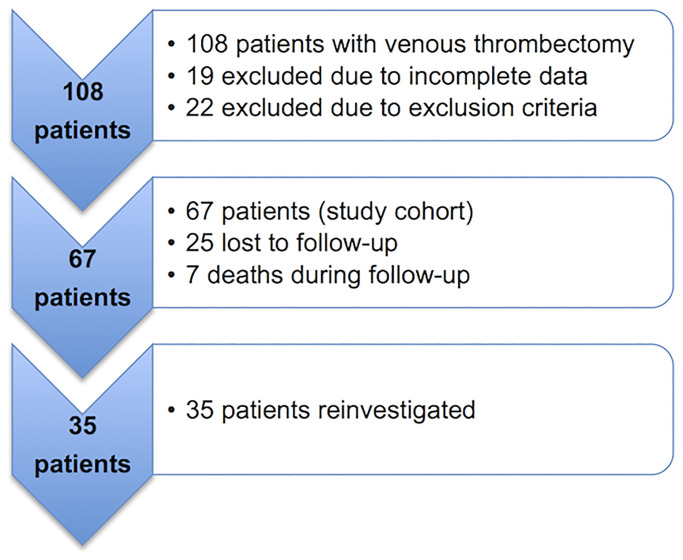
Patient recruitment.A total of 67 patients were included. 35 patients could be reinvestigated after a mean follow-up of 102 months (minimum 26,6 maximum 197,6).